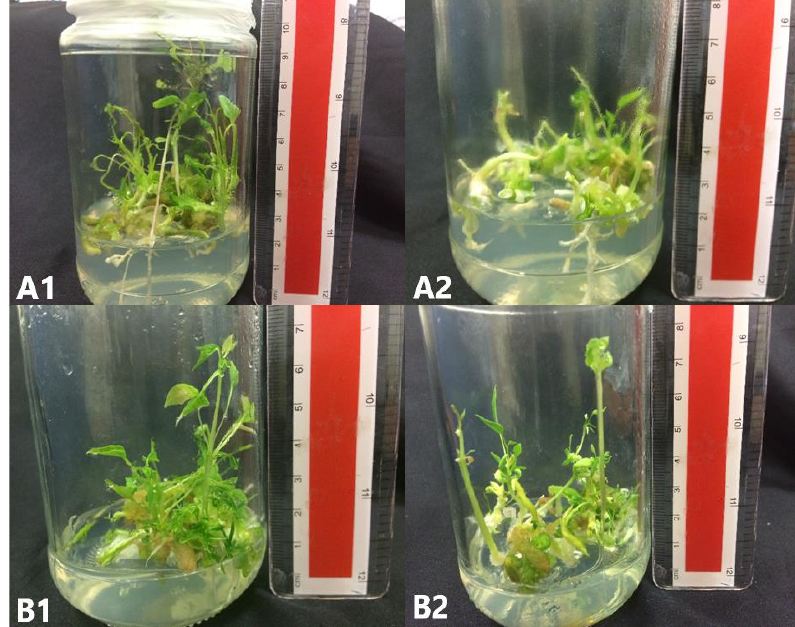
Figure 8. C. papaya “Eksotika” in elongation media A1 and A2 , explant germinated in EL1 media. B1 and B2 , explant germinated in EL2 media.